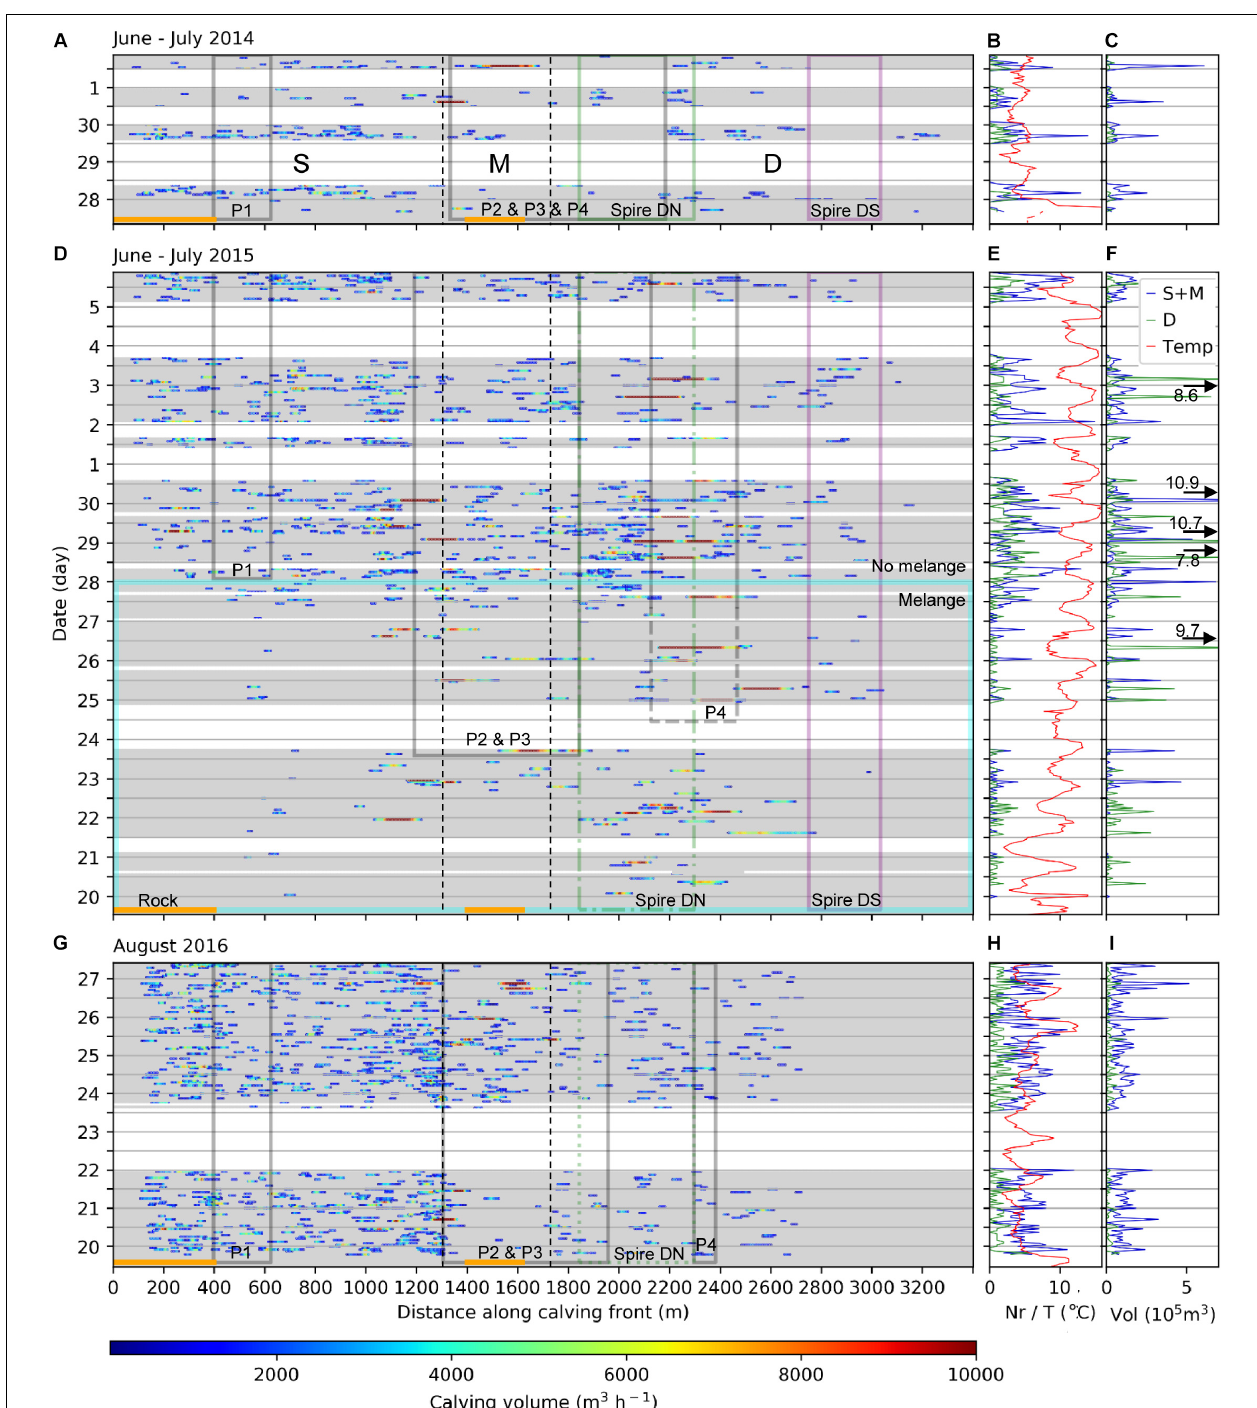
FIGURE 12 | Calving event volumes along the front over time for the field campaigns in (A) 2014, (D) 2015, and (G) 2016. Calving volumes sampled during 1 h intervals are color coded. White areas indicate data gaps. The orange horizontal bars correspond to bedrock visible above the waterline. The gray boxes indicate the location and presence of meltwater plumes. Plumes P2, P3, and P4 can merge together. The black dotted vertical lines separate the sectors shallow (S), middle (M), and deep (D). The northern spire in sector D (DN) is indicated with a green box with a solid frame if the spire is still high, a dash-dotted frame if the spire is retreating and a dotted frame if the spire is in its low state ( Figure 9 ). The southern spire in sector D (DS) is marked with a purple box. Number of events and temperature over time are shown in the middle panels for the field campaigns in (B) 2014, (E) 2015, and (H) 2016. The right panels show the volume of events over time for the field campaigns in (C) 2014, (F) 2015, and (I) 2016. Number and volume of calving events per hour are separated into the shallow (blue line, together with the middle) and deep sector (green line).